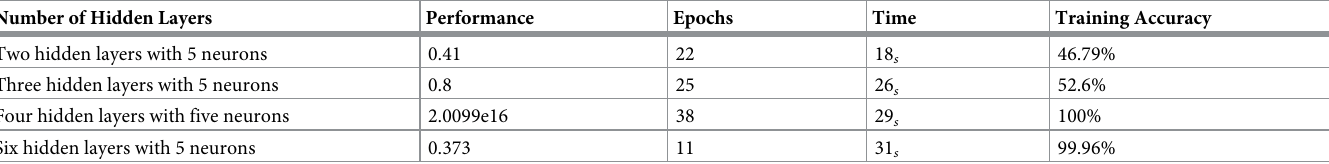
Table 3. Accuracy rate with different numbers of layers and neurons.